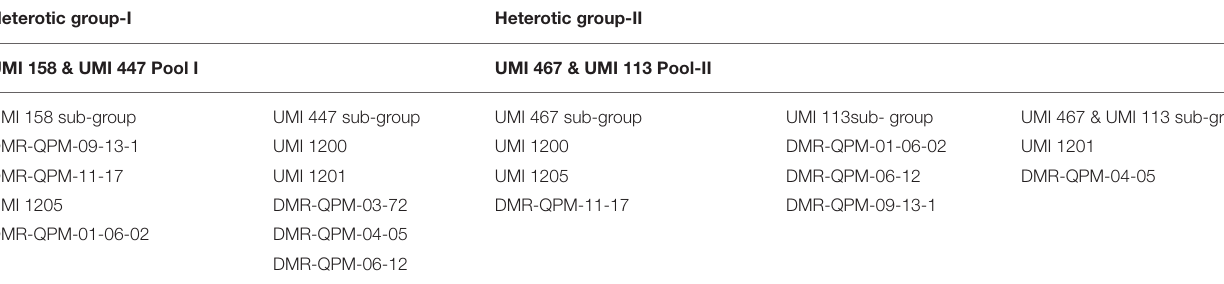
TABLE 7 | The grouping of the lines in the tester groups based on their combining ability. Heterotic